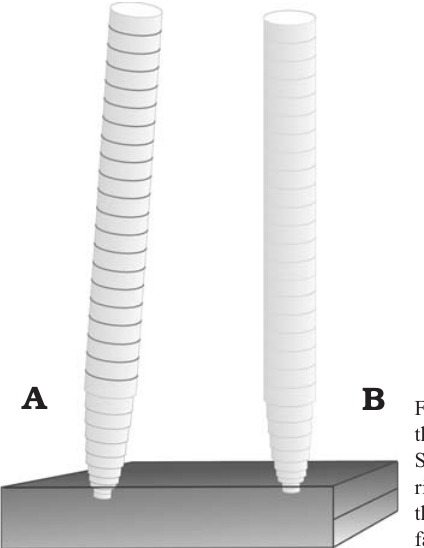
Fig. 3. Reconstruction of the tubes in life position. Specimens with shallow rings ( A ) and with very thin striation on their sur- face ( B